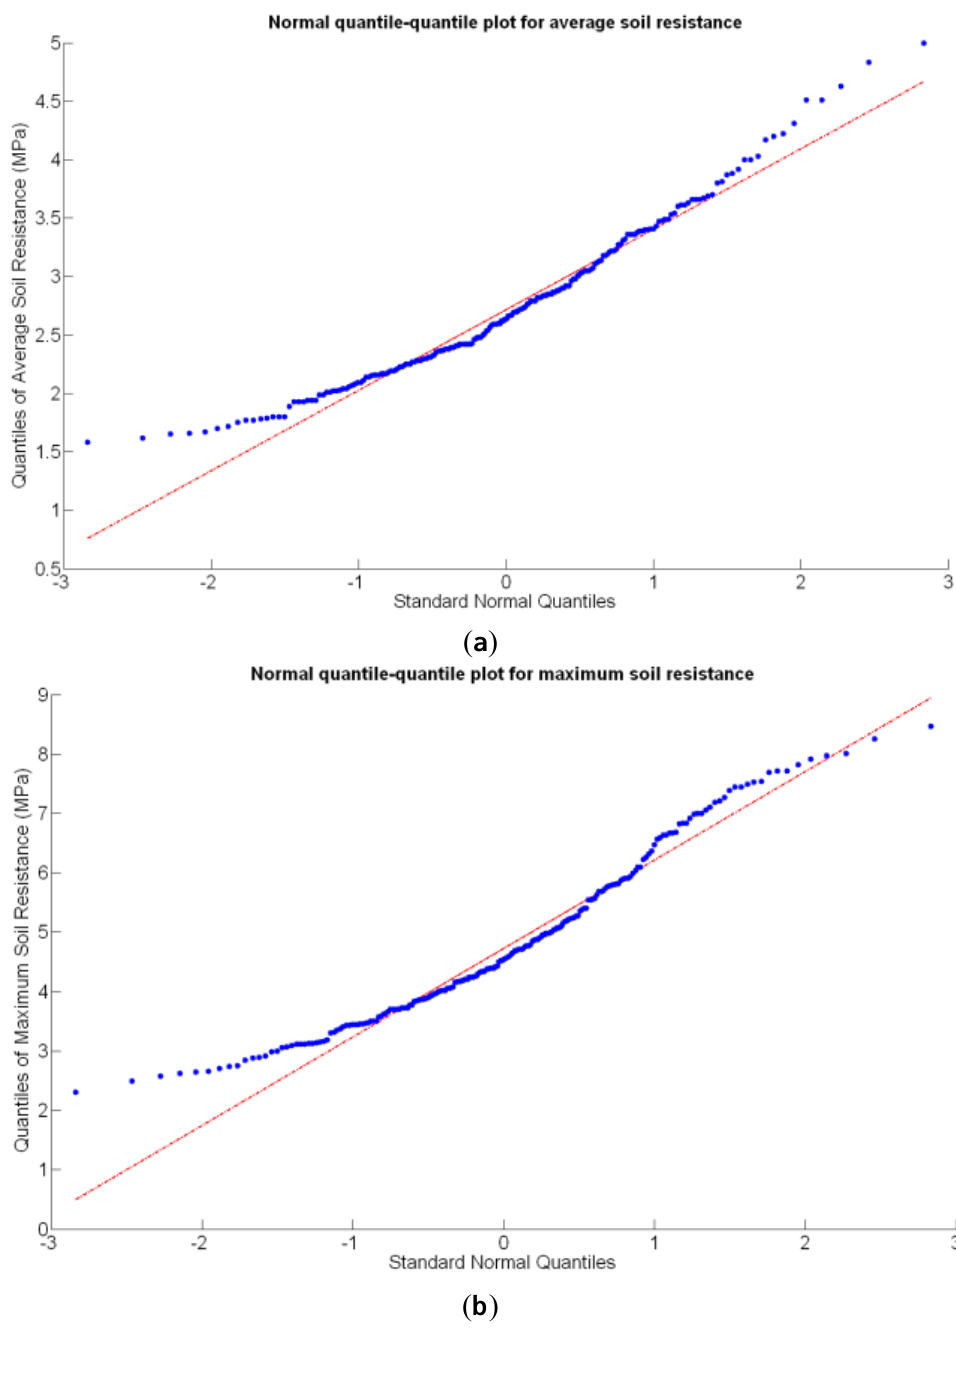
Figure 16. Normal quantile-quantile plots for soil resistance (MPa): ( a ) Average values; ( b ) Maximum